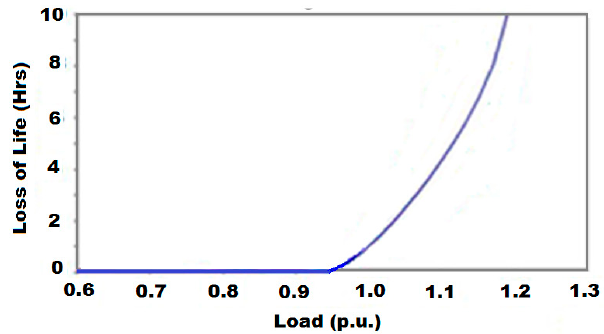
Figure 1. Paper insulation aging as a function of per unit load for a 50 kVA liquid immersed transformer.